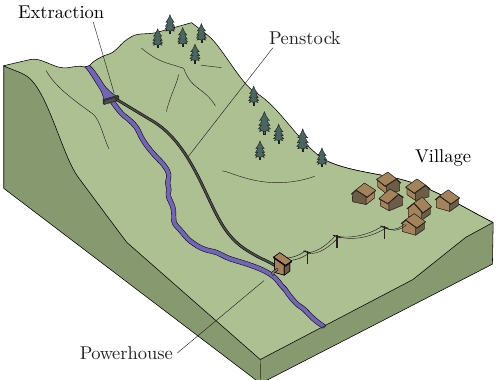
Figure 1. Basic scheme of an